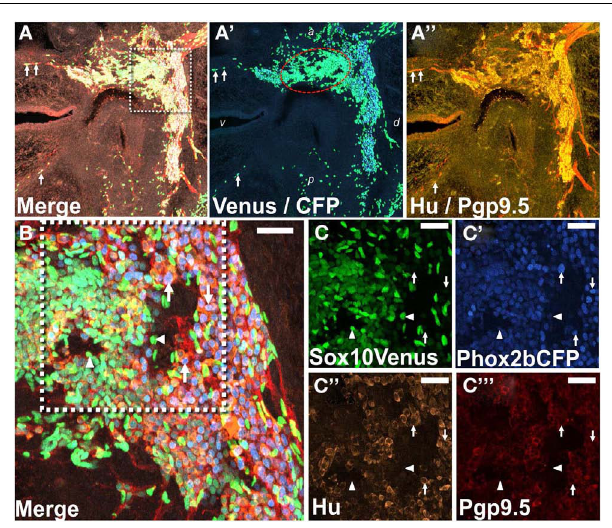
FIGURE 7 | Regional segregation of NC-derived progenitors and neurons within fetal pelvic ganglia . (A) Cryosection through the lateral sagittal plane of pelvic ganglia collected from Phox2b -H2BCFP, Sox10 -H2BVenus double transgenic female fetal mouse stained for PGP9.5 and Hu shows the overall triangular shape of the pelvic ganglia at 15.5dpc. Merged confocal image at 200 × magnification captures nuclear Sox10-H2BVenus (green), nuclear Phox2b-H2BCFP (blue), cytoplasmic PGP9.5 (red), and Hu (gold). Differentiating neurons in the bladder wall identified by residual nuclear H2BVenus expression are co-labeled by up-regulation of cytoplasmic PGP9.5 (arrows). (A (cid:48) ) Confocal image showing channels only forVenus and CFP from the cryosection presented in (A) is shown. An oval domain comprised of densely packed Sox10 + cells (green nuclei, encircled by red dotted line) is evident with Phox2b + neurons (blue nuclei) being most numerous outside this region. (A (cid:48)(cid:48) ) A confocal image shows channels for PGP9.5 and Hu from the cryosection presented in (A) . PGP9.5 (red) labels numerous cell bodies at the dorsal aspect of the pelvic ganglia, a small area of differentiating neurons nearest the anterior bladder neck, and extrinsic nerve fibers entering the ganglia. Hu (gold) labels numerous cell bodies with the greatest density being around the perimeter of the pelvic ganglia. (B) Higher magnification confocal image (400 × ) from the boxed region in (A) shows high density of H2BVenus + progenitors in the core of the oval progenitor domain with Phox2b + , PGP9.5 + , Hu + neurons clustered at the dorsal aspect of the pelvic ganglia. Single confocal channels at 630 × magnification from boxed area in (B) are shown for Sox10 -H2BVenus [ (C) , green], Phox2b -H2BCFP [ (C (cid:48) ) , blue], Hu + neuronal soma [ (C (cid:48)(cid:48) ) , gold], PGP9.5 + differentiating neurons [ (C (cid:48)(cid:48)(cid:48) ) , red]. Progenitor cells labeled by H2BVenus nuclear fluorescence (arrowheads) exhibit low or no expression of Phox2b -H2BCFP and no expression of PGP9.5 and Hu. Differentiating neurons lack H2BVenus label, exhibit bright Phox2b -H2BCFP nuclear fluorescence as well as cytoplasmic Hu and PGP9.5 labeling (arrows). Dorsal (d), ventral (v), anterior (a), and posterior (p) orientations are indicated on (A (cid:48) ) . Scale bar: 25 µ m.